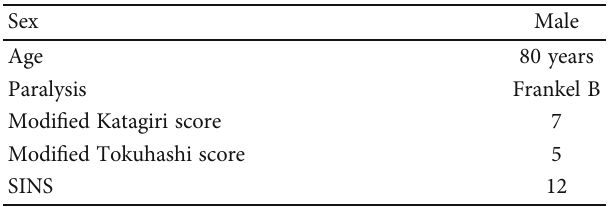
Figure 3: 3D CT showing the pathological fracture occurred within the range of DISH, which suggested a hyperinstability. Table 1: Patients ’ clinical summary and evaluation based on scoring